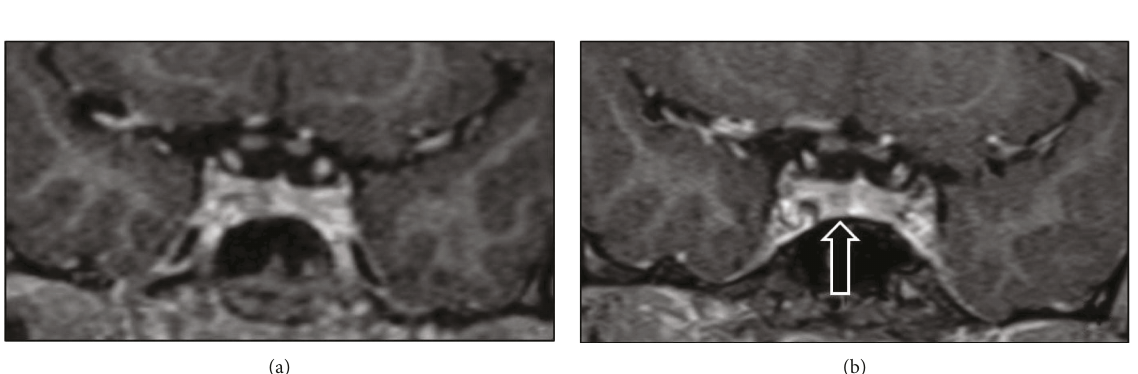
Figure 5: Pituitary MRI scans of the proband ’ s fi rst cousin (case 5), showing a normal pituitary at the age of 9 (a), and three years later, a 3mm microadenoma became visible in her pituitary gland